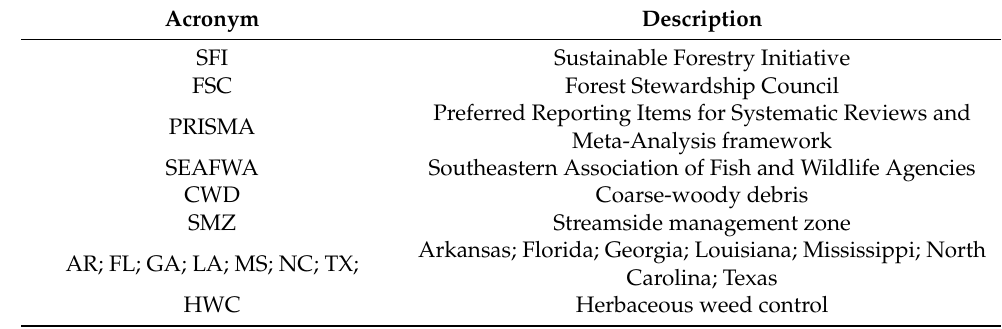
Table 1. List of acronyms and their associated descriptions relative to factors of southeastern U.S. pine management and listed in order of appearance in the